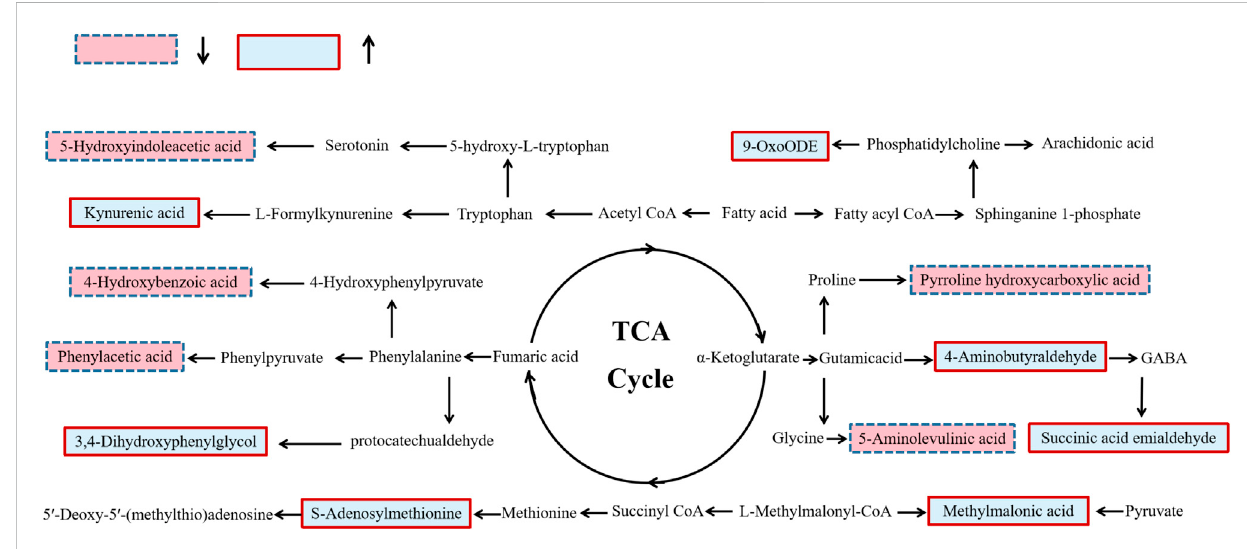
Schematic diagram of metabolic pathway related to rhubarb anthraquinone treated rat acute liver injury. The boxes bordered in red represent metabolites that are signi fi cantly higher in NC, RA-L, RA-M and RA-H than in ALI, respectively. The light blue boxes indicate metabolites signi fi cantly higher in ALI than in NC, RA-L, RA-M and RA-H